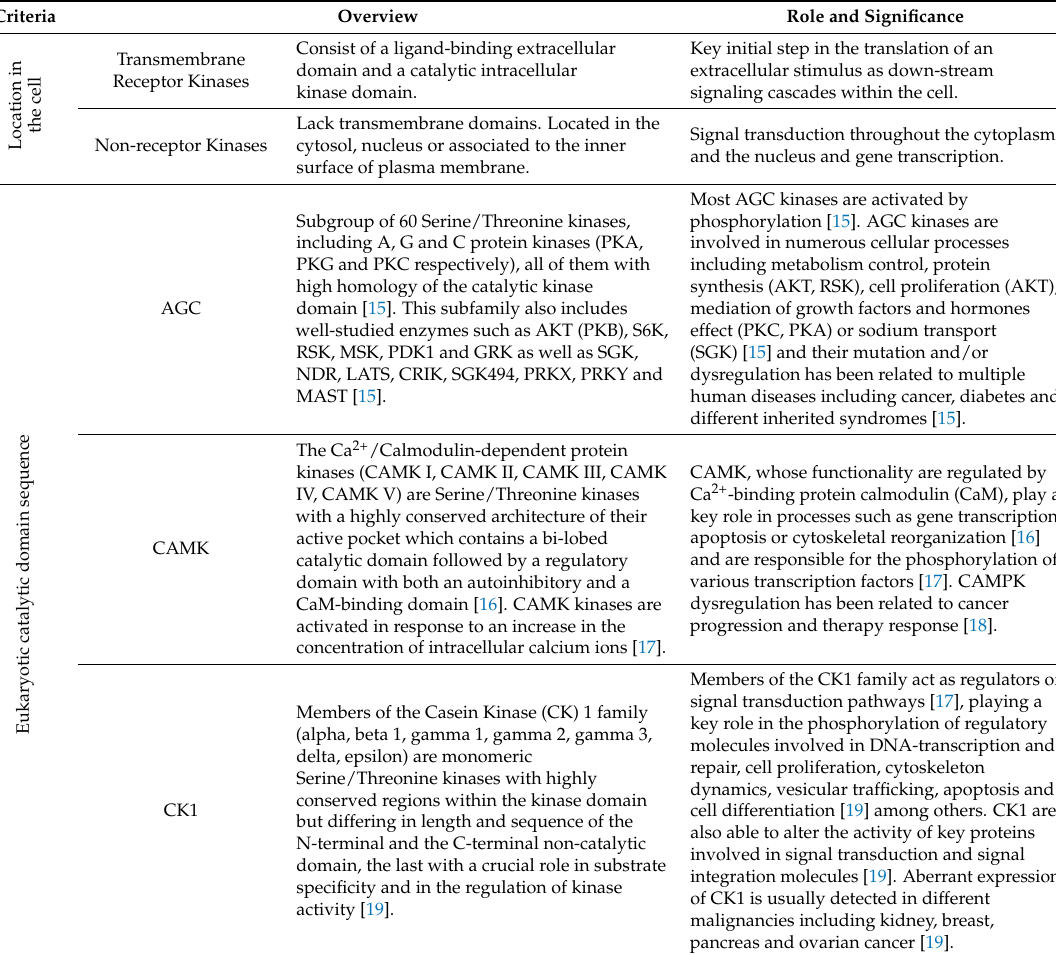
Human protein kinases classification based on cell location and catalytic core sequence